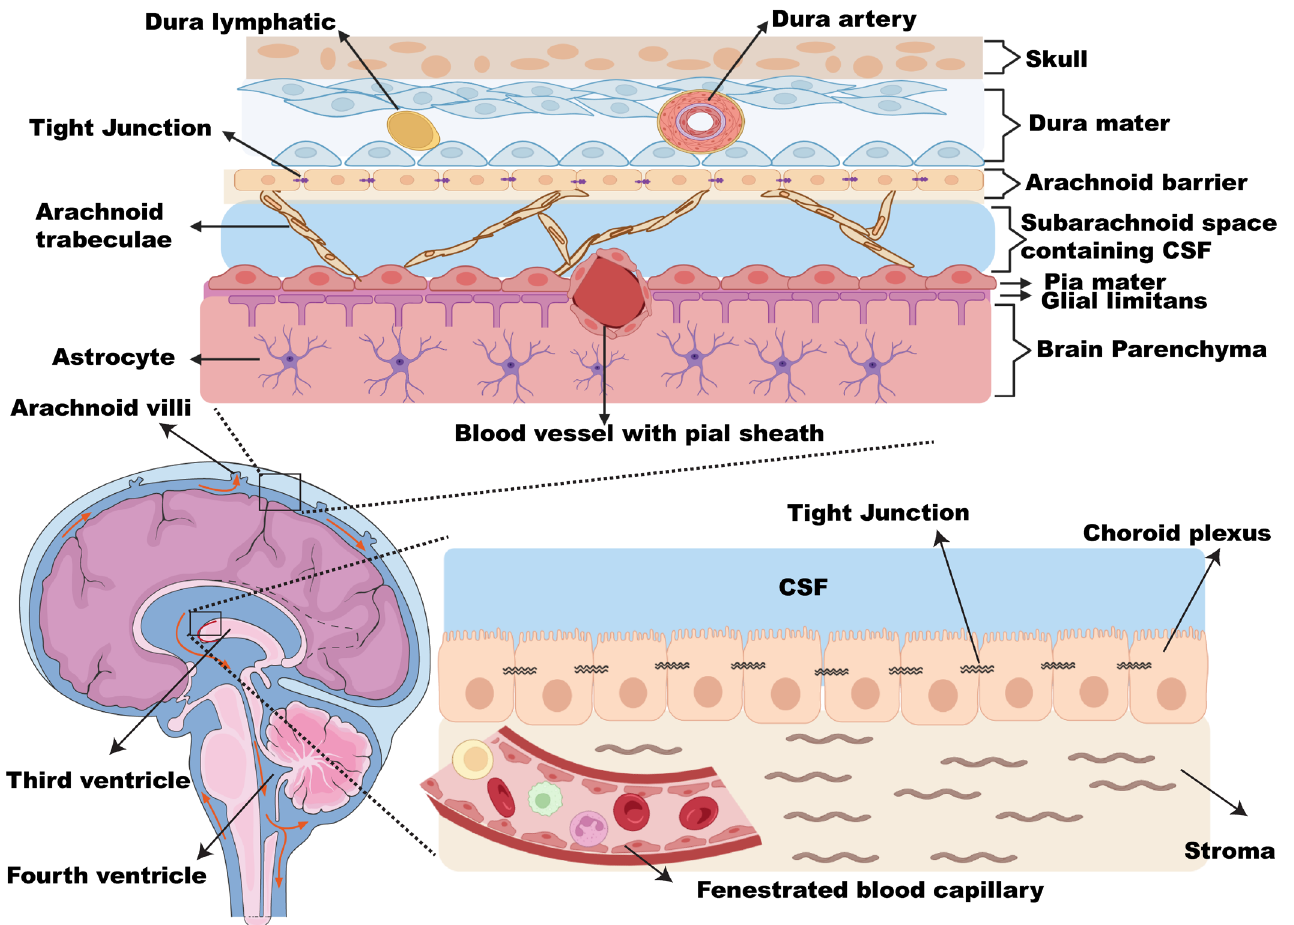
Figure 1. The leptomeninges and CSF biology. The side view of the brain demonstrates the third and fourth ventricles where the cerebrospinal fluid (CSF) flows (red arrows). The upper square shows the three layers of the meninges covering the brain. The lower square represents the blood–CSF barrier and shows the choroid plexus layer, the specialized lining of the brain ventricles.